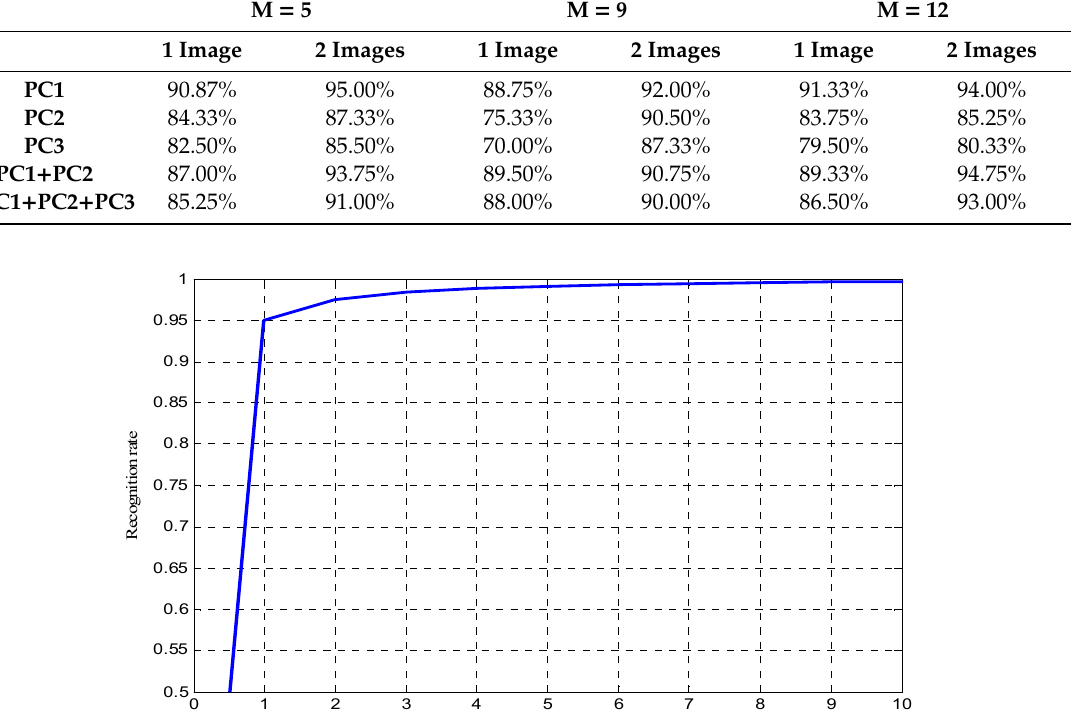
Figure 10. Cumulative match characteristic (CMC) curve of face unimodal biometric system performed on the facial recognition technology (FERET) face database.